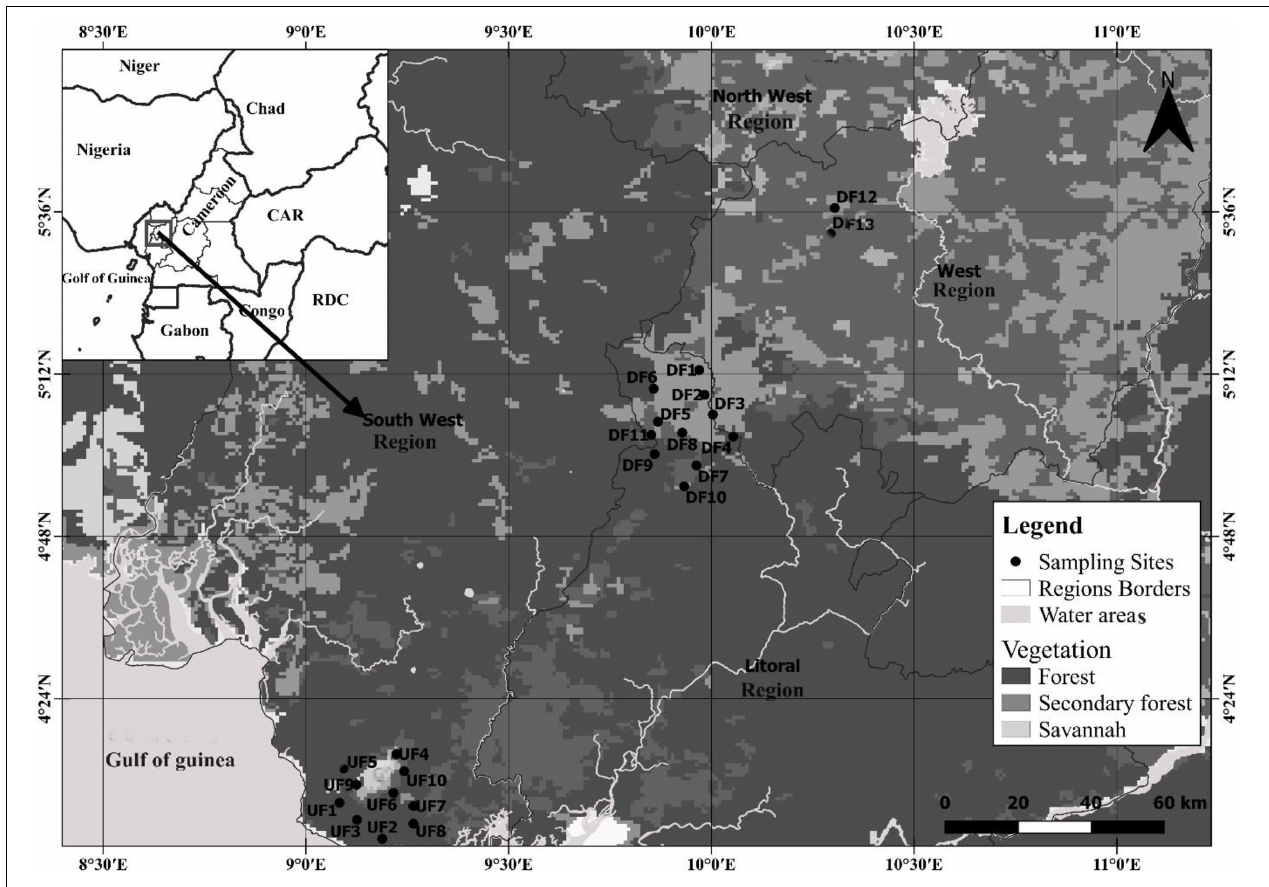
FIGURE 1 | Map showing undisturbed habitat sites (UF) and disturbed habitat sites (DF) sampled for bats in the Afromontane biome of western Cameroon from June 2019 to March 2020.